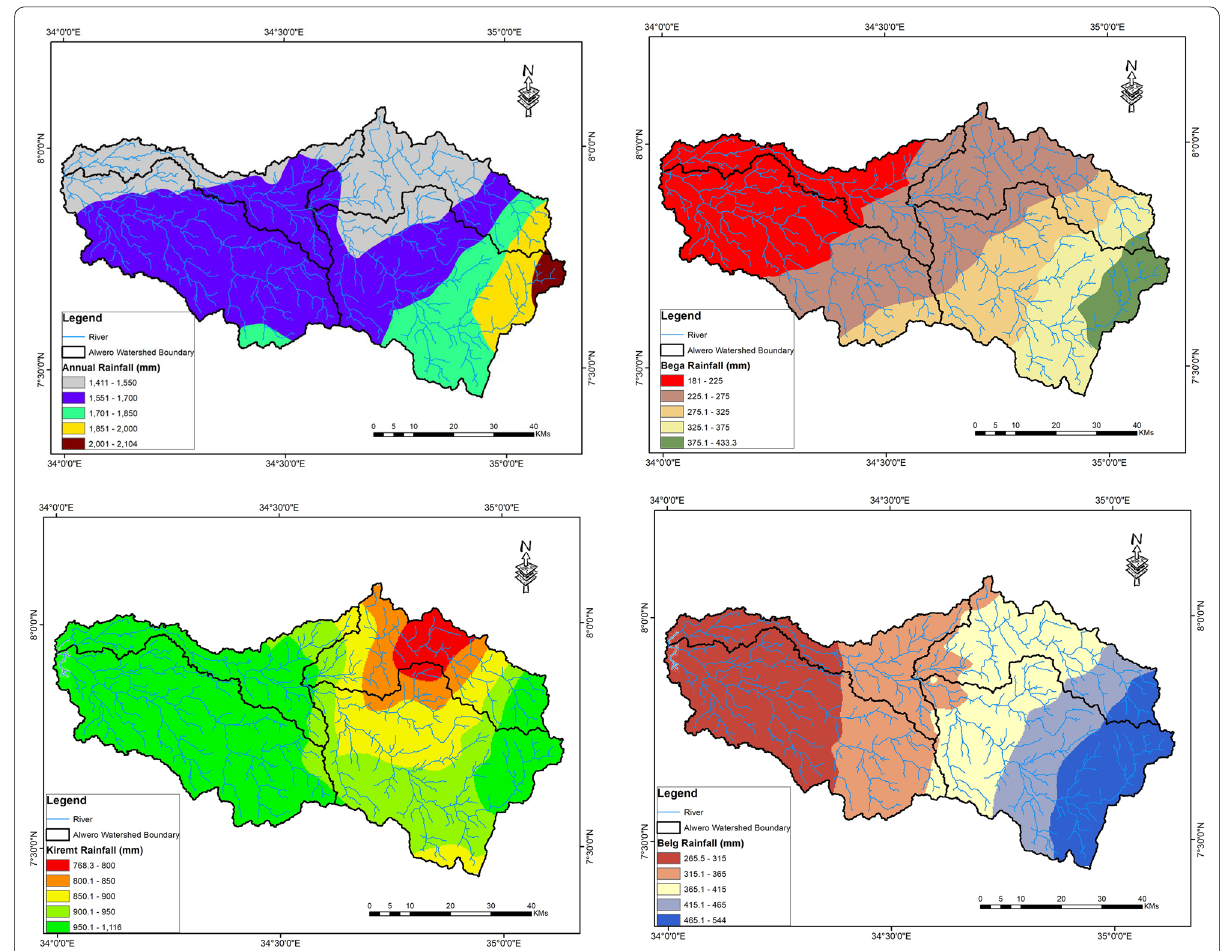
Fig. 4 Spatial distribution of annual and seasonal rainfall in Alwero